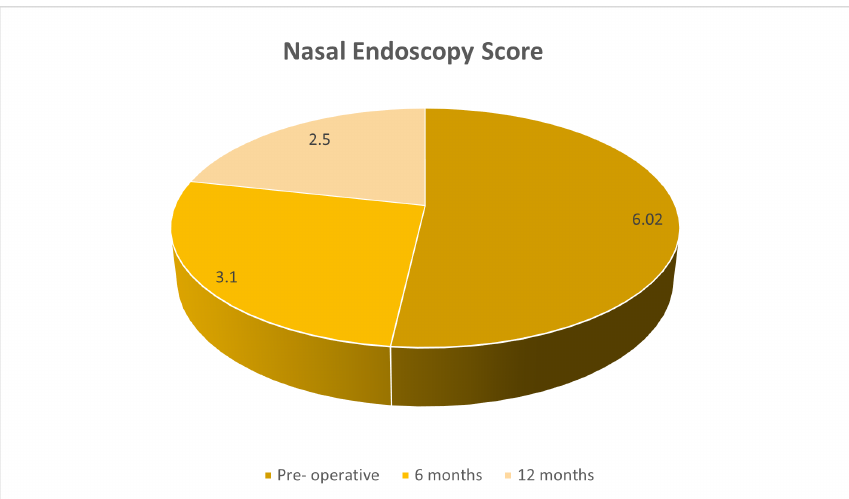
Figure 2. Calculation of Nasal Endoscopy